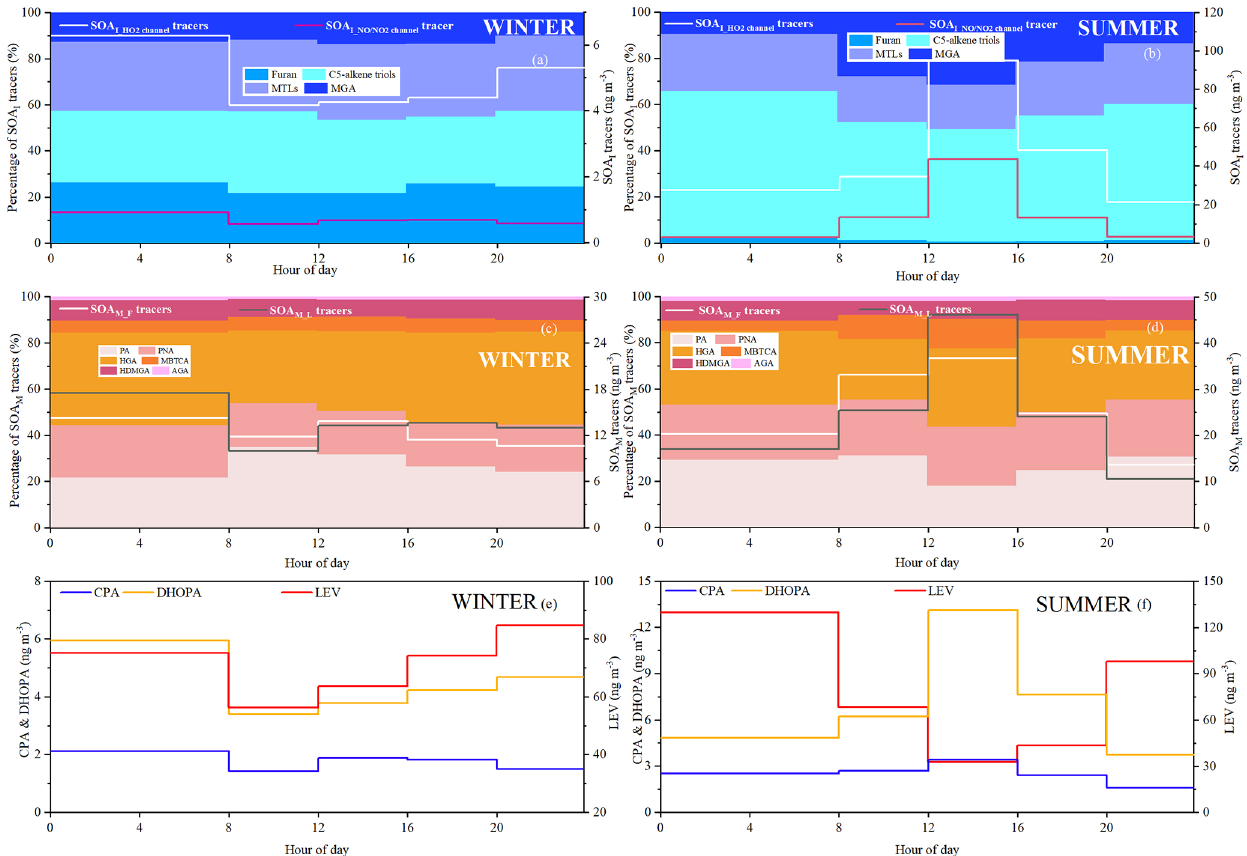
Figure 2. Diurnal variation of individual SOA tracers during winter (a, c, e) and summer (b, d, f) .